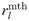
Histograms of the estimated values of rlmth.